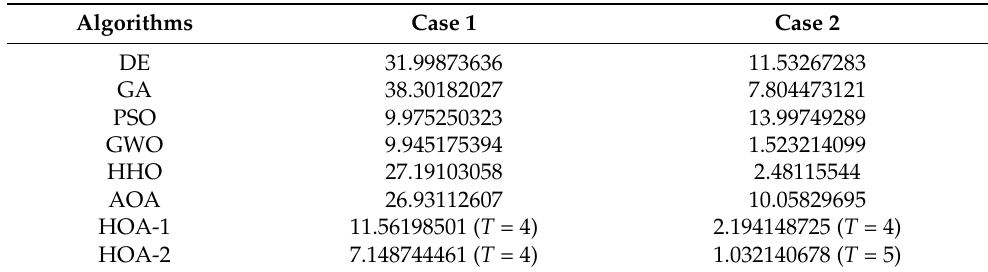
Table 9. Results of two